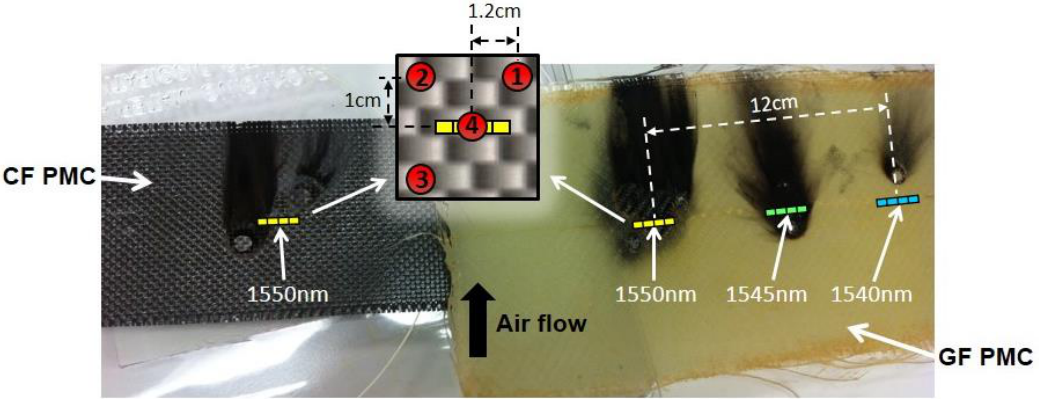
Figure 4. Polymer matrix composite (PMC) specimens tested for their high temperature response. Sensor positions in each PMC are indicated by their nominal Bragg wavelength. Air flow to remove smoke was upwards across each composite. CF: carbon fiber GF: E-glass fiber.